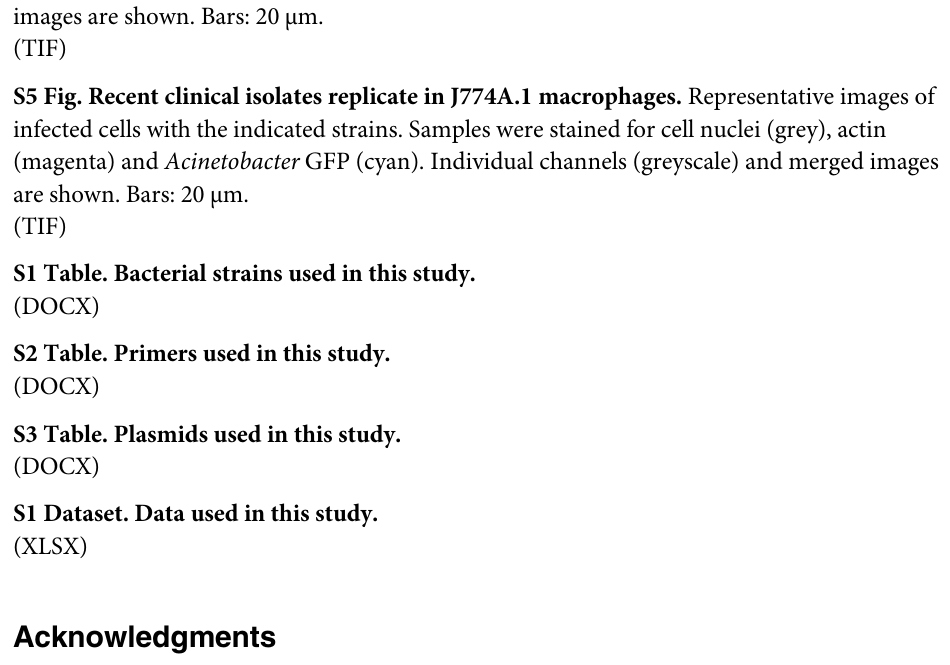
S2 Fig. UPAB1 replicates in multiple host cell lines. Representative Z-projections with orthogonal views of infected J774A.1 cells (left panel) or BMDM (right panel) at 7 and 5 h p.i., respectively. Samples were stained for cell nuclei (grey), actin (magenta) and Acinetobacter GFP (cyan). Bars: 20 μ m. White arrows indicate the vacuole. (TIF) S3 Fig. UPAB1 ACVs are LC3 negative. Representative images of J774A.1 macrophages (A) non-infected, (B) Serratia marcescens -infected (2 h p.i.), or (C) UPAB1-infected (1, 2.5 and 5 h p.i.). Samples were stained for cell nuclei (grey), LC3 (magenta) and bacteria expressing GFP (cyan). Individual channels (greyscale) and merged images are shown. Insets show a higher magnification of the area indicated by the white box. Bars: 20 μ m. (TIF) S4 Fig. UPAB1 replicates in multiple host cell lines. Representative images of infected THP- 1 (upper panels) or BMDM (lower panels) cells at 5 h p.i. Samples were stained for cell nuclei (grey), actin (magenta) and UPAB1 GFP (cyan). Individual channels (greyscale) and merged images are shown. Bars: 20 μ m. (TIF) S5 Fig. Recent clinical isolates replicate in J774A.1 macrophages. Representative images of infected cells with the indicated strains. Samples were stained for cell nuclei (grey), actin (magenta) and Acinetobacter GFP (cyan). Individual channels (greyscale) and merged images are shown. Bars: 20 μ m. (TIF) S1 Table. Bacterial strains used in this study. (DOCX) S2 Table. Primers used in this study. S3 Table. Plasmids used in this study. (DOCX) S1 Dataset. Data used in this study.